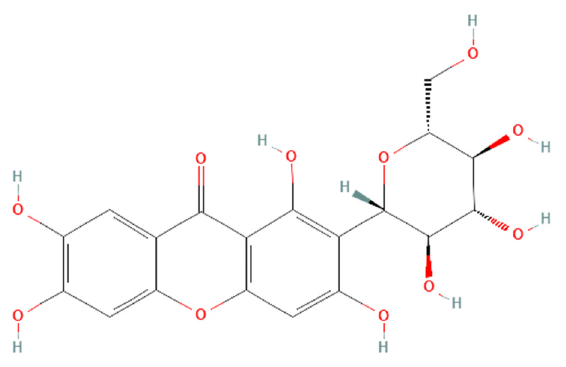
Figure 1. Structure of mangiferin (PubChem CID 5281647).